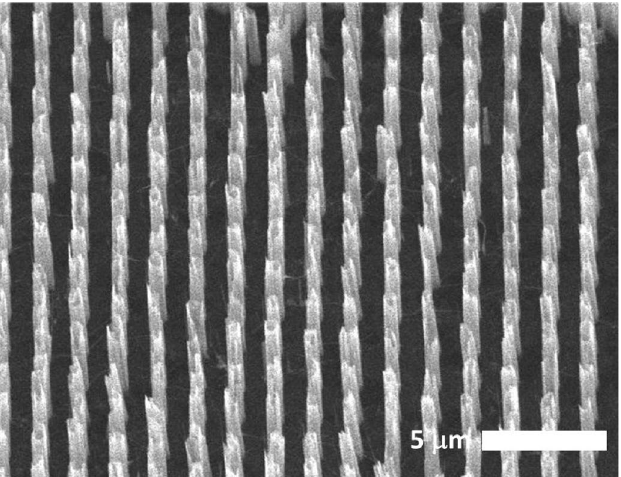
Figure 2. Scanning Electron Microscope (SEM) image displays the ZnO nano-rods. The rods have a length of 5 µm and are separated by 1